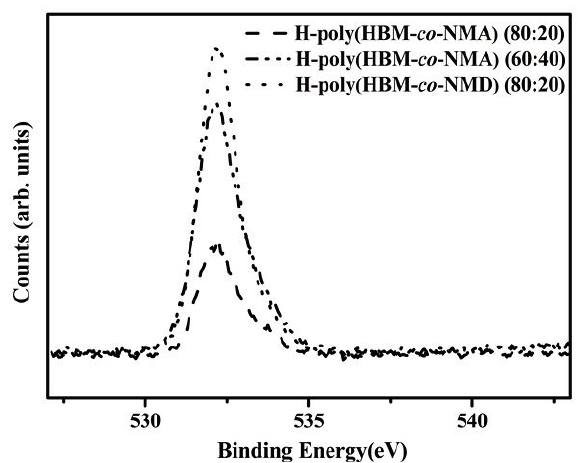
Figure A10. O 1s X-ray Photoelectron Spectroscopy spectra of